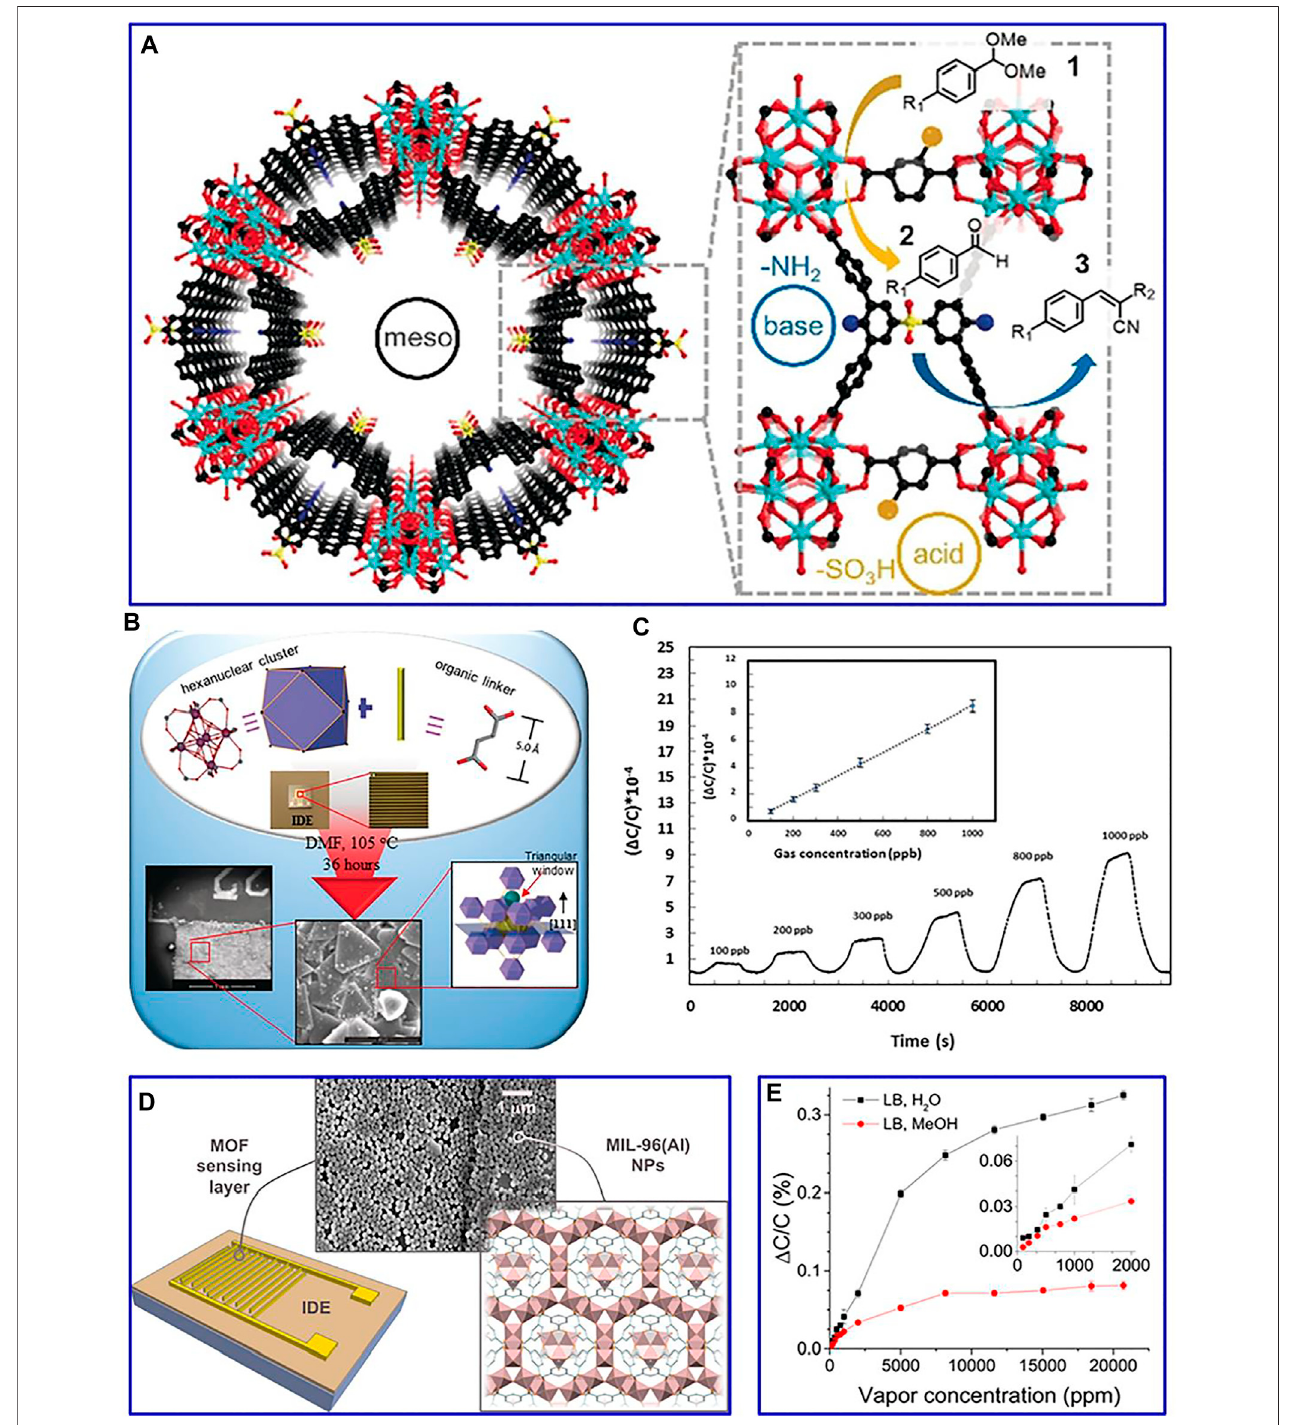
FIGURE 4 | (A) One-pot tandem reaction of benzaldehyde dimethylacetal and malononitrile by bifunctional mesoporous catalyst. Reproduced with permission (Feng et al., 2019). Copyright 2019, Wiley. (B) Schematic of the prepared approach of the fumarate-based fcu-MOF; (C) detection of H 2 S with concentrations of 1 – 100 ppm. Reproduced with permission (Yassine et al., 2016). Copyright 2016, Wiley. (D) Illustration of the structure of the used IDEs showing the MOF LB fi lm characterization by SEM; (E) normalized capacitive response of IDEs to water and methanol. Reproduced with permission (Andrés et al., 2020). Copyright 2020, ACS.